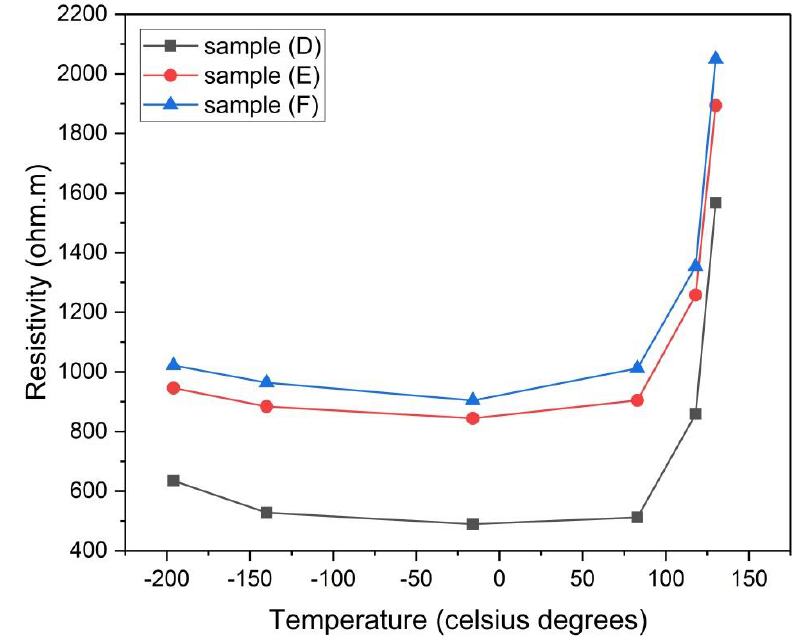
Figure 17. Electrical resistivity of samples (D), (E) and (F) versus the temperature of analysis.